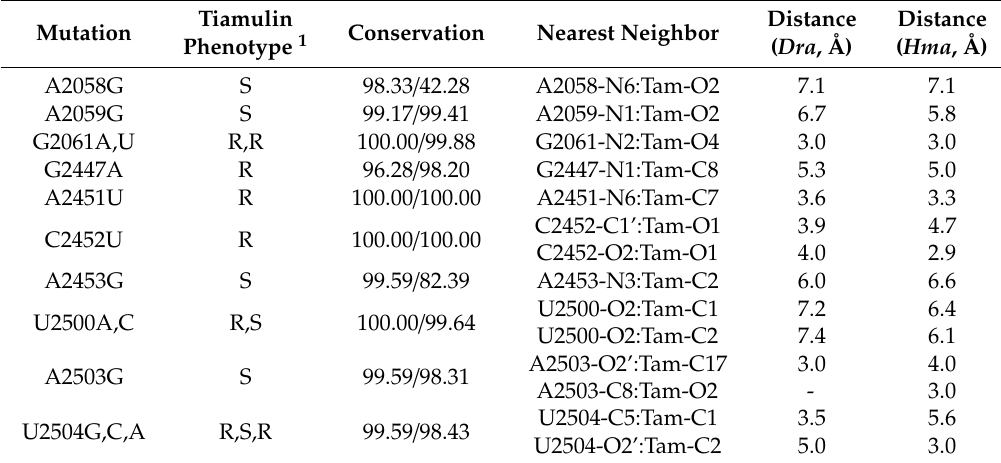
Table 3. Closest approaches of 23S rRNA bases and